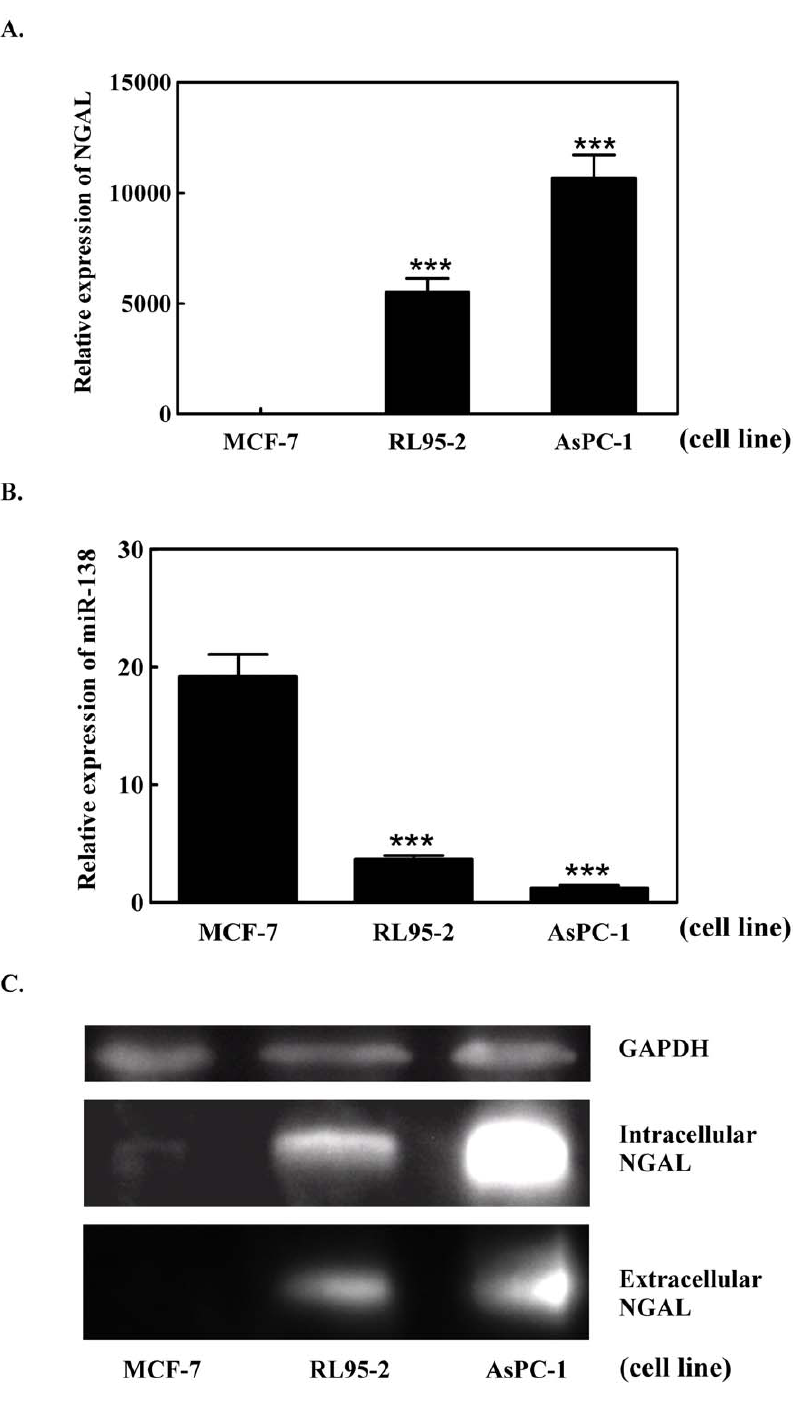
Figure 2. Expression of NGAL mRNA, miR-138 and the NGAL protein in three different cancer cell lines. (A) NGAL mRNA levels measured by qPCR; (B) miR-138 expression levels measured using the TaqMan MicroRNA assay; and (C) detection of intracellular and extracellular NGAL protein determined by western blot analysis in the three cancer cell lines, MCF-7, RL95-2 and AsPC-1. doi:10.1371/journal.pone.0052979.g002 secondary antibody at 1:4,000 dilution. Reactions were carried out at room temperature for 10 min. Gel bands were visualized by enhanced chemiluminescence according to the manufacturer’s protocol. GAPDH served as an internal loading control and was detected using monoclonal rabbit anti-GAPDH antibody (Abcam, Cambridge, UK) at 1:4,000 dilutions.